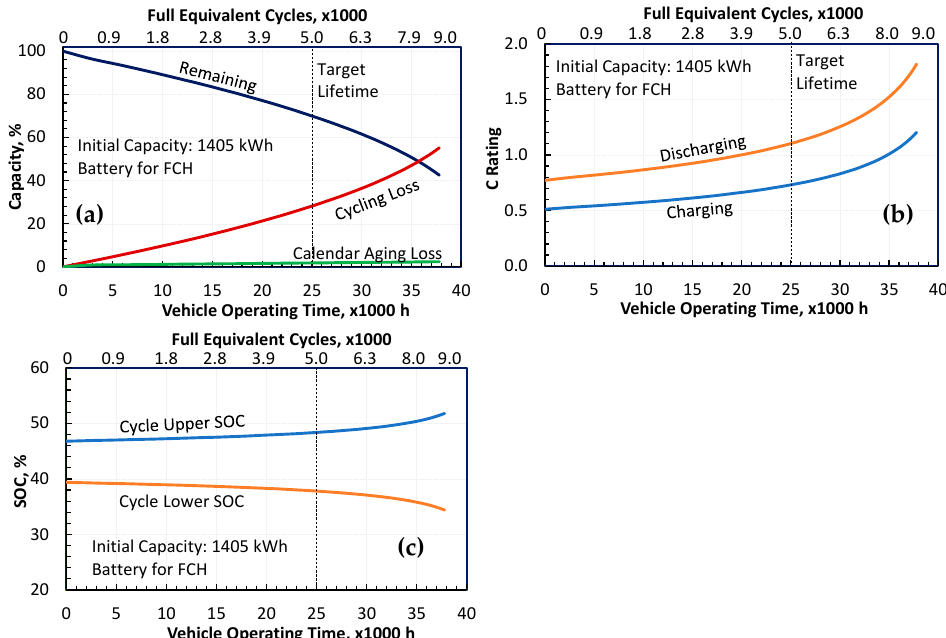
Figure 4. Illustration of battery capacity sizing methodology to achieve 25,000 h operating life by controlling the charge and discharge C-rates, mean SOC, and DOD: ( a ) Capacity fade; ( b ) Average C-rates for charge and discharge; ( c ) Upper and lower SOC.